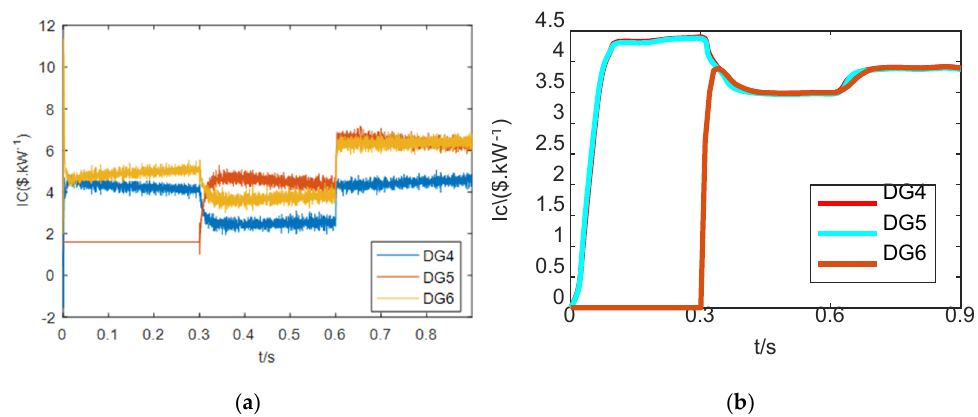
Figure 6. Distribution of AC subnet cost increment. ( a ) Cost increment distribution diagram of AC subnet with traditional droop control. ( b ) Cost increment distribution of AC subnet based on OPPRA.